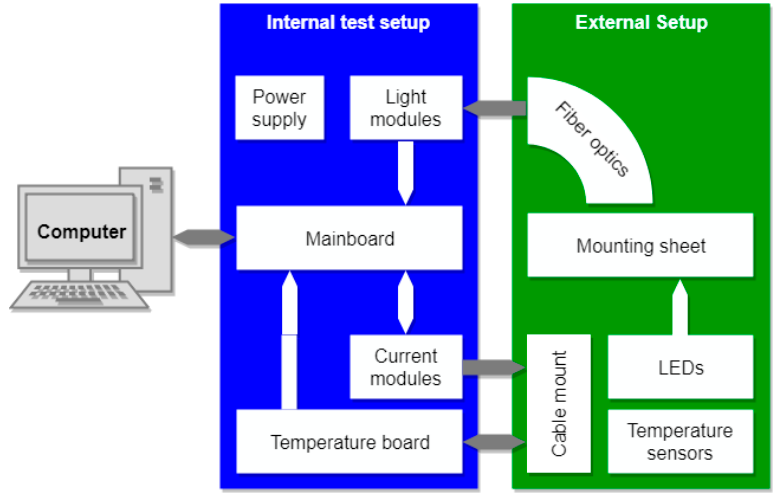
Figure 1. Overview of the test setup.